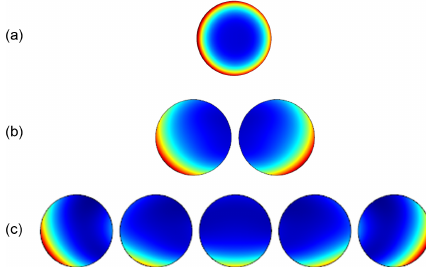
Figure 5. Illustration of the different skin effect regimes in the sec- tion of one, two and five turns: (a) usual skin effect, (b) proximity skin effect and (c) lateral skin effect.